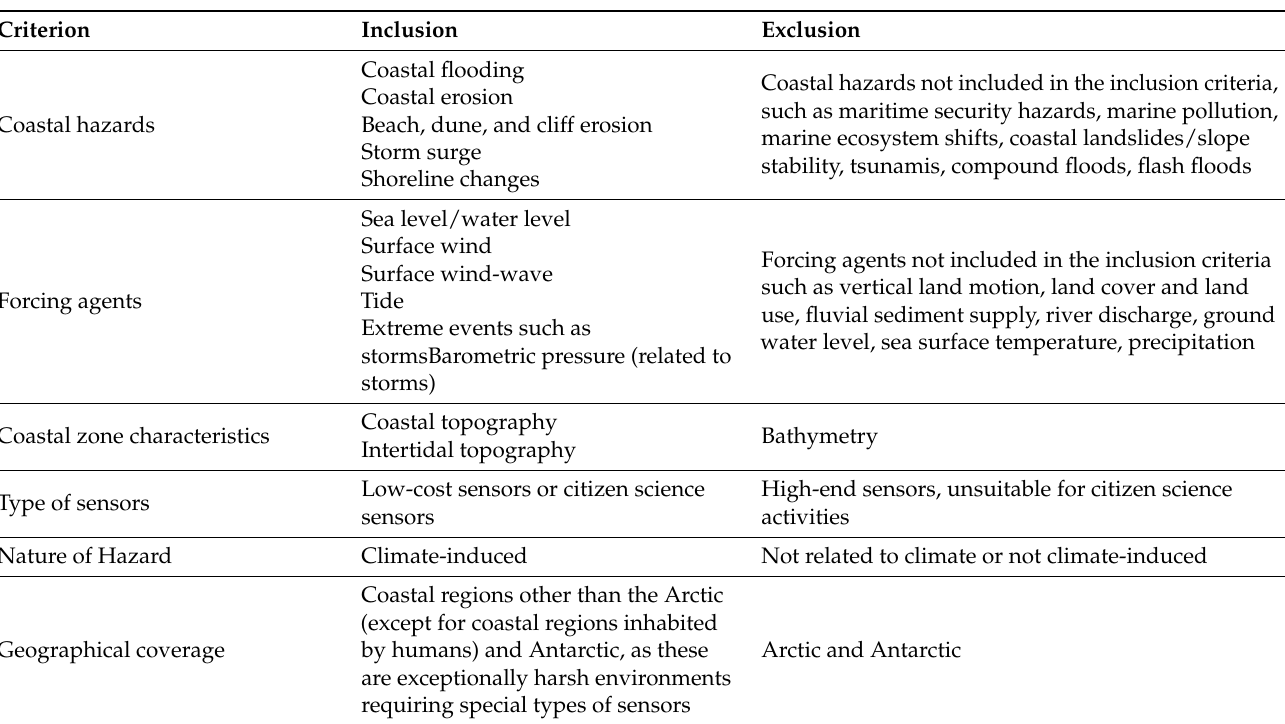
Table 2. Inclusion/exclusion criteria for the selection of relevant articles from the systematic search of peer-reviewed